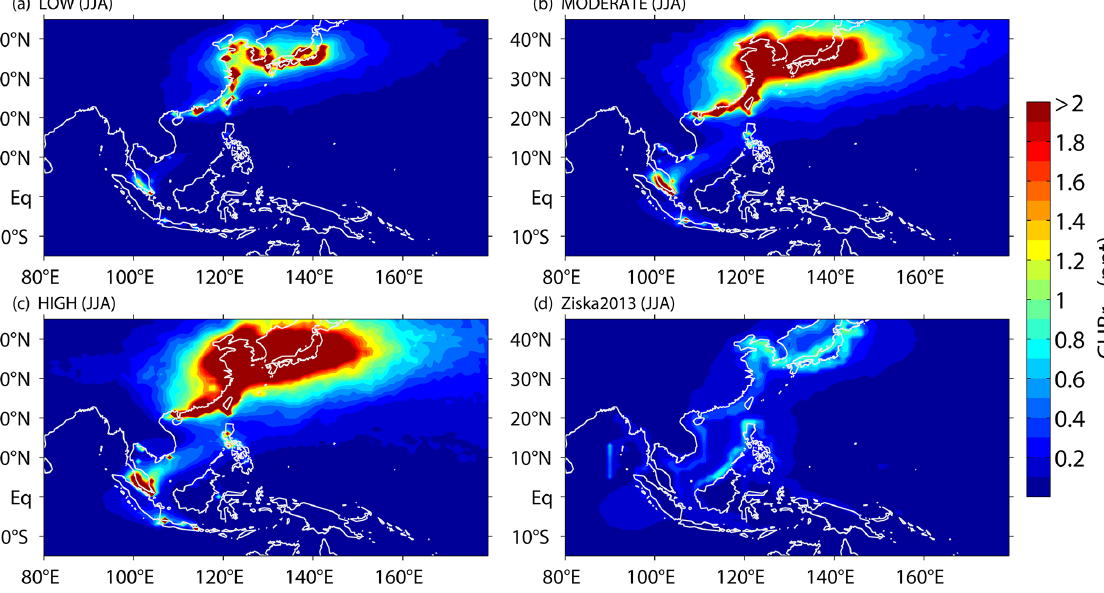
Figure 6. Seasonal mean bromoform mixing ratios [ppt] in 50m height during JJA derived from FLEXPART runs driven by the three scenarios (a) LOW, (b) MODERATE, (c) HIGH, and (d)